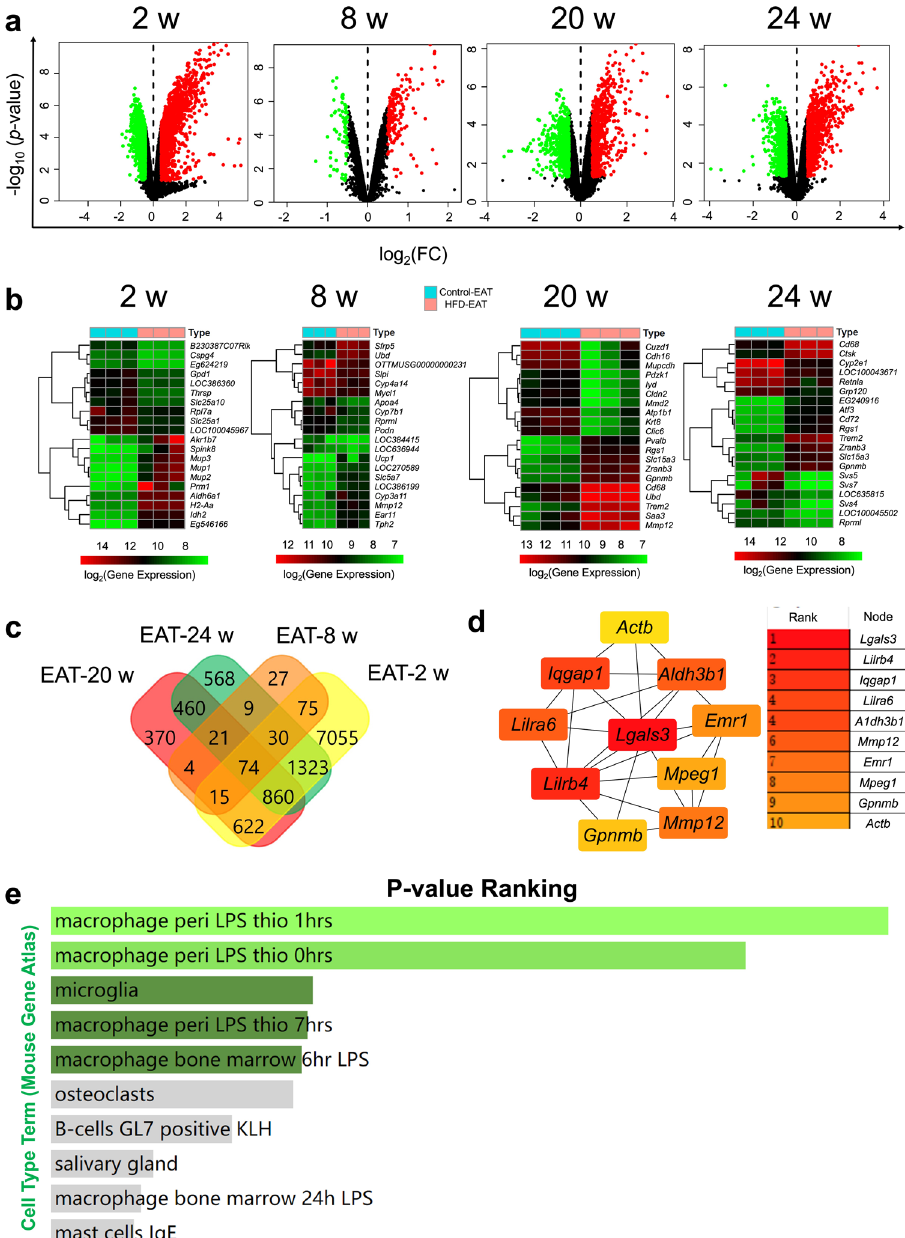
Fig. 1 Differential gene mining between control-EAT and HFD-EAT based on the GEO database. a Identi fi cation of the differentially expressed genes between control-EAT and HFD-EAT at different time courses (2, 8, 20, and 24 weeks). The red and green spots in the HFD group were classi fi ed by the upregulated genes and downregulated genes compared with the control, respectively. b Heatmap of the top 10 upregulated and top 10 downregulated DEGs in HFD-EAT compared with control-EAT at different time courses (2, 8, 20, and 24weeks), and the color bar represents differential gene expression magnitude. c Venn plot of the differentially expressed genes at different time courses. d Top 10 predicted hub genes that could be in fl uenced by the different dietary habits (control or HFD) with high combined scores. (Darker red indicates higher combined scores to be hub genes). e Mouse Gene Atlas of overlapping differential genes in the different time courses based on the Enrichr online